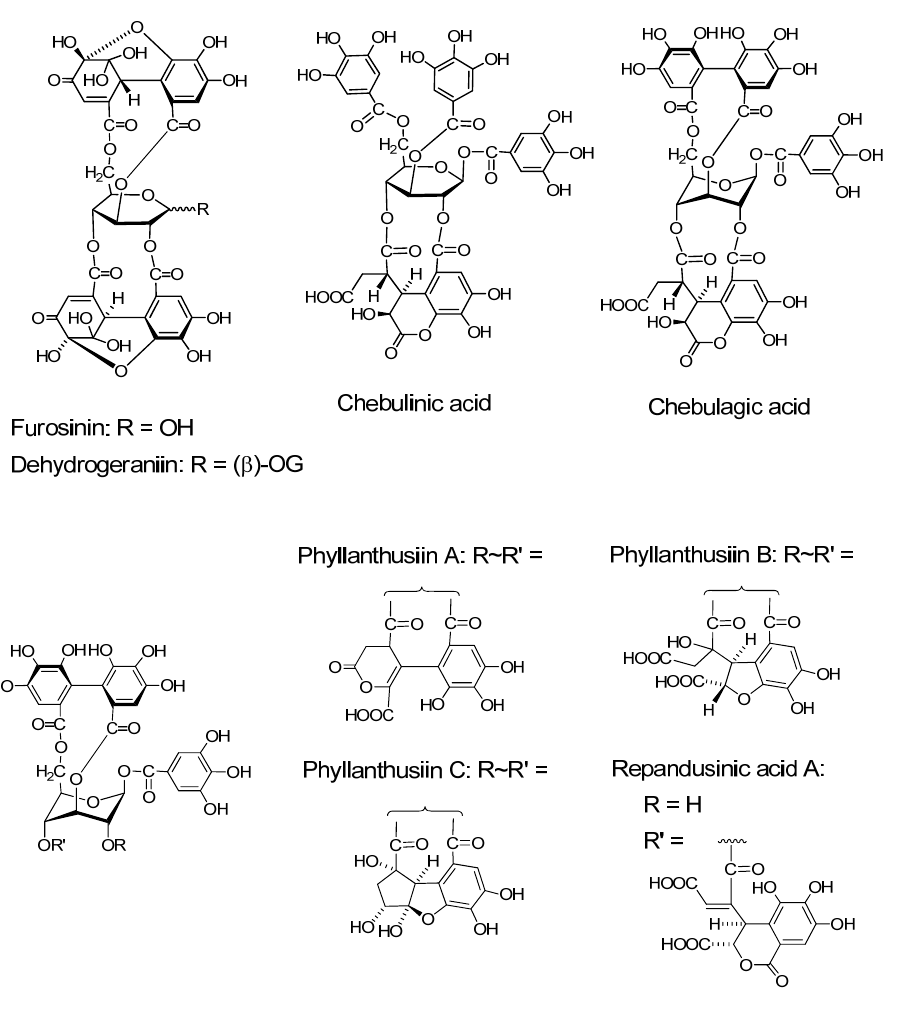
Figure 5. Condensation products from